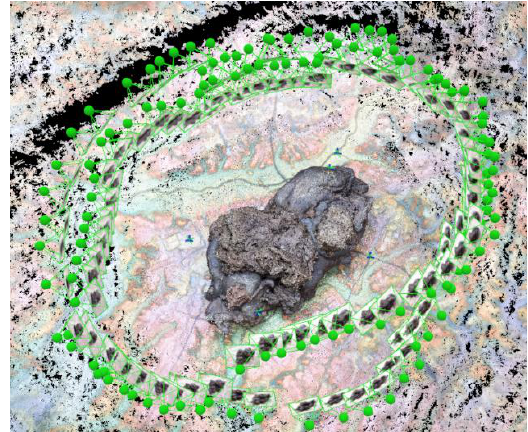
Figure 8. Point cloud B generated from image set B and estimated camera position and